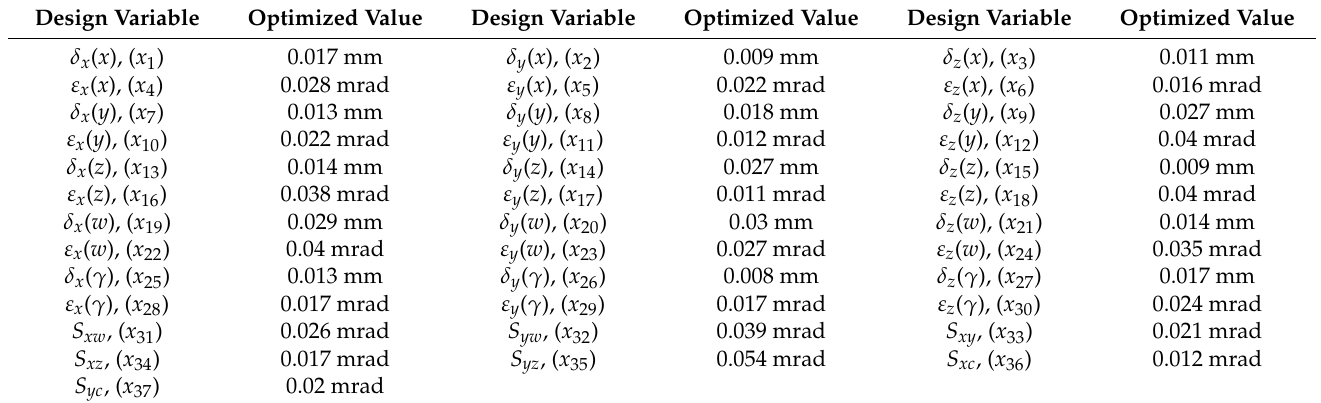
Table 5. The optimal solution of stiffness distribution obtained by genetic algorithm optimization.